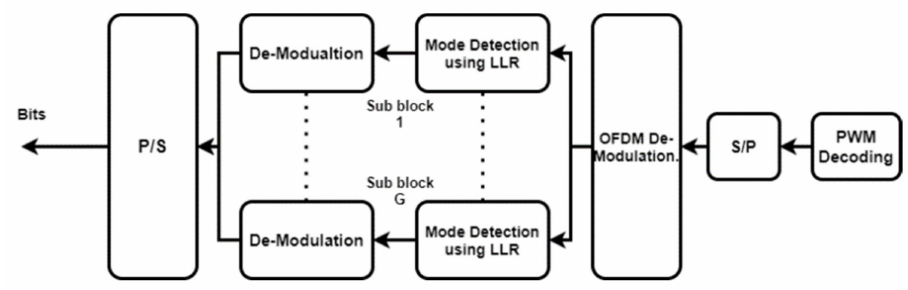
Figure 5. Receiver block diagram of OFDM-IM.